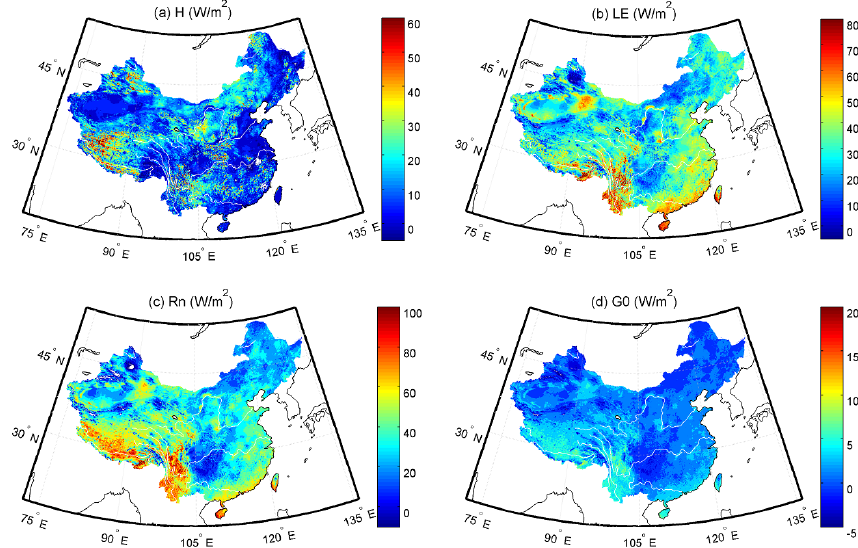
Figure 8. Maps of multiyear (2001–2010) means of retrieved fluxes: (a) sensible heat flux ( H ), (b) latent heat flux (LE), (c) net radiation (Rn), and (d) ground heat flux ( G 0 ). White lines show several major rivers in China.